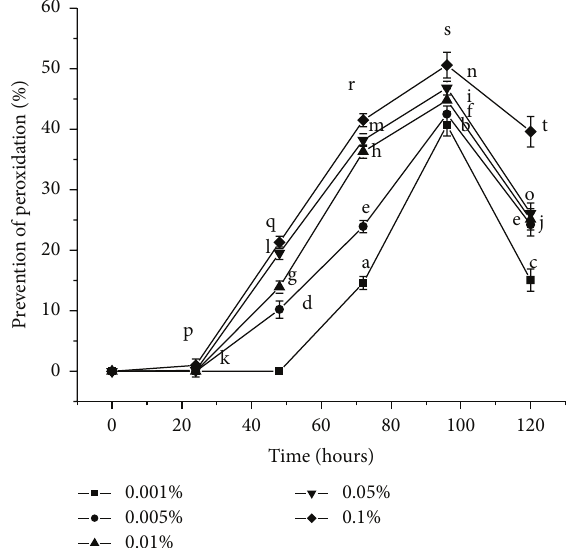
Figure 7: Prevention of lipid peroxidation by 𝛼 - and 𝛽 -carotene crystals at different concentrations. Values are Mean ± S.E.M of